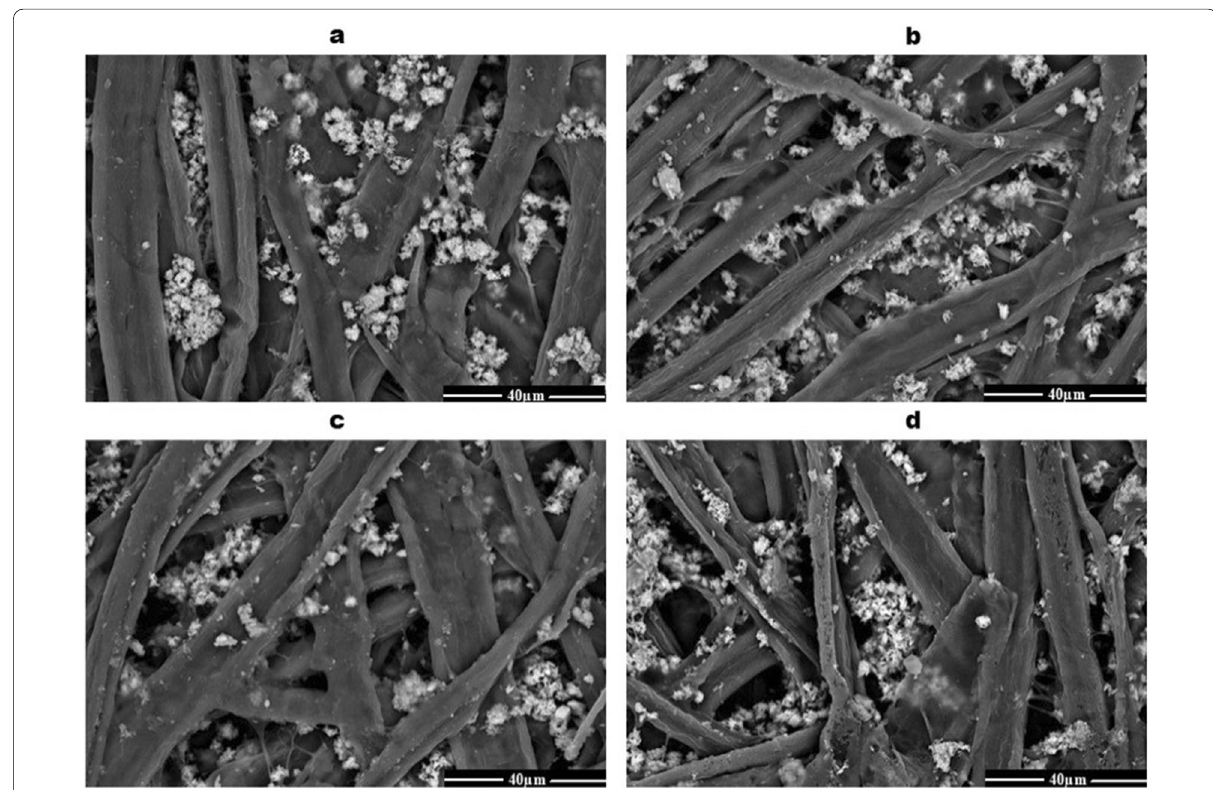
Fig. 6 SEM micrograph of the paper structure after exposure to the gamma radiation doses. Control ( a ), 6 kGy ( b ), 12 kGy ( c ), and 24 kGy ( d